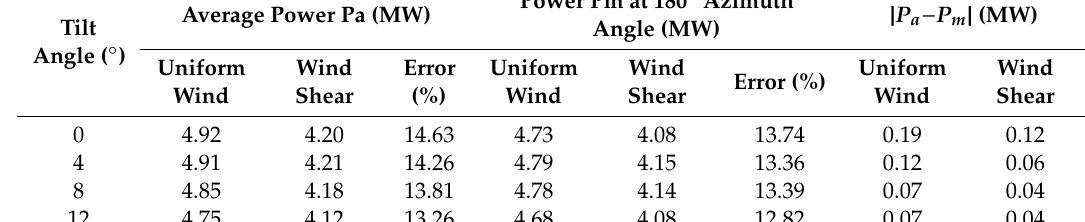
Table 8. Power for uniform wind and wind shear flow conditions at 𝑉 (cid:3035)(cid:3048)(cid:3029) = 11.4 m/s ( γ = 0.2, 𝐼 (cid:3045)(cid:3032)(cid:3033) = 0.14).